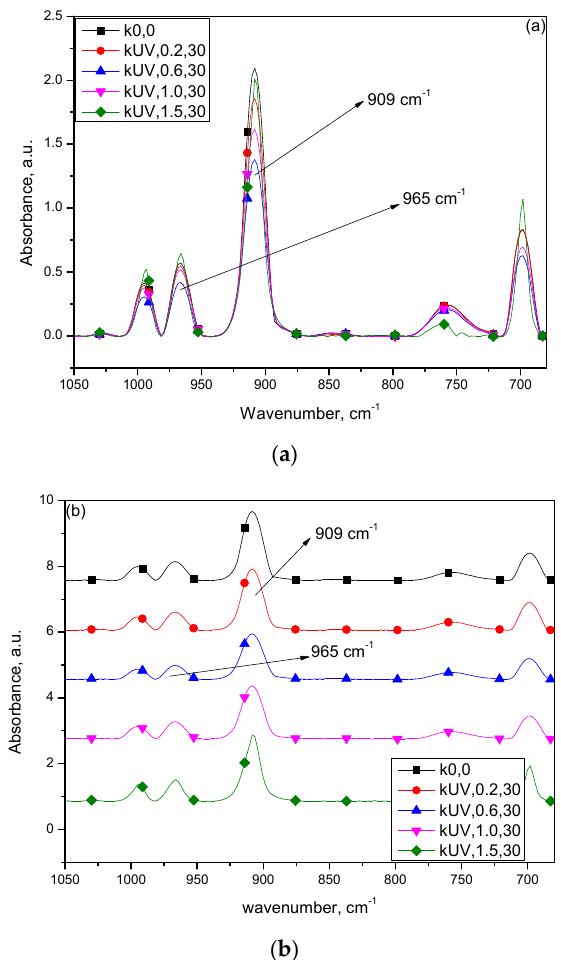
Figure 9. Baseline-fitted and subtracted spectra of the control sample and selected 30 s irradiated samples ( a ) superimposed and ( b ) the spectra stacked by Y offsets.